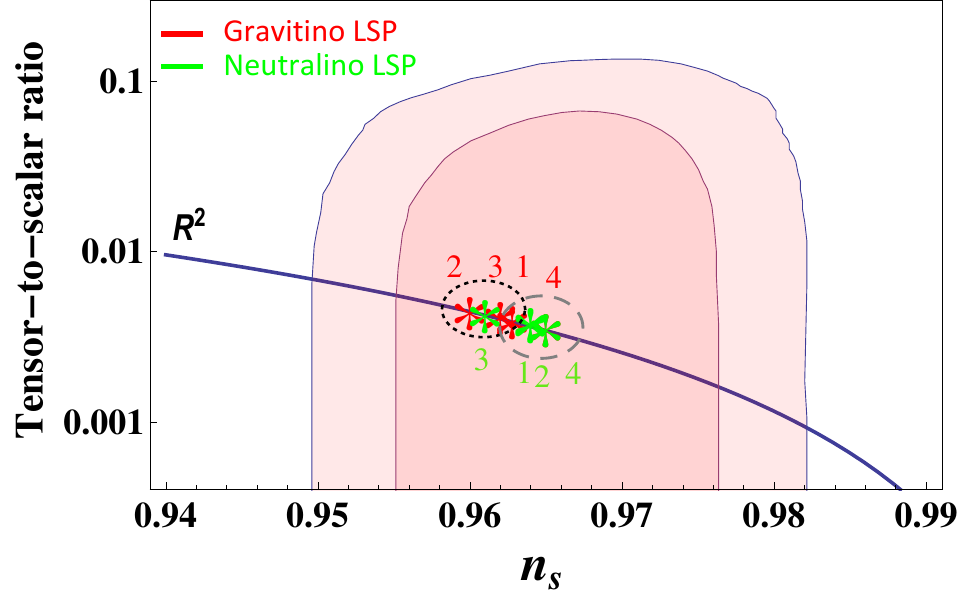
Figure 8 . Constraints on the ( n s ; r ) contour plane from Planck-2015 in the pink, and the schematic illustration of 2 (cid:27) forecast constraints from a future CMB probe with sensitivity (cid:14)n s (cid:24) 10 (cid:0) 3 and (cid:14)r (cid:24) 10 (cid:0) 3 depicted with the dotted and dashed ellipsis. The R 2 model is targeted with a (cid:12)ducial value of r (cid:24) 4 (cid:2) 10 (cid:0) 3 . The red asterisks correspond to the predictions of the four benchmark models (#1 ; 2 ; 3 ; 4) with gravitino LSP and the green asterisks to the four benchmark models (#1 ; 2 ; 3 ; 4) with neutralino LSP, as explained in the text and tables 1 and 2 respectively. If the future CMB experimental probes select the area inside the dashed ellipsis then either the R 2 or the SUGRA- R 2 in(cid:13)ation model is selected plus a roughly continuous thermal phase with reheating temperature, T rh (cid:24) 10 9 GeV. The selection of the dashed ellipsis area will exclude a large class of